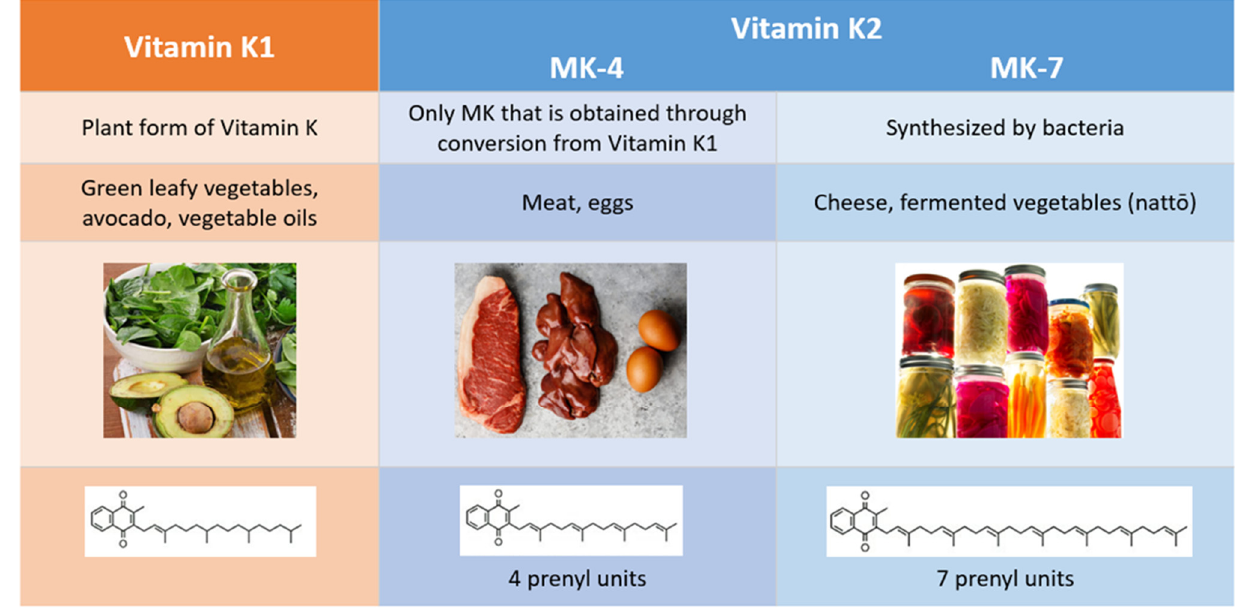
Figure 2. Differences between vitamin K1 and vitamin K2.